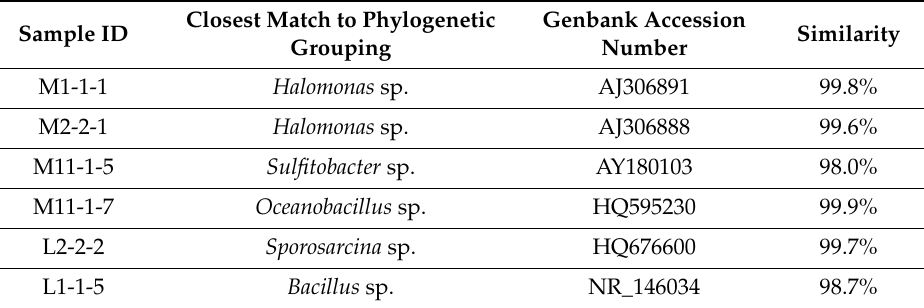
Table 3. P hylogenetic grouping of the isolated bacterial strains. Table 3. Phylogenetic grouping of the isolated bacterial strains.